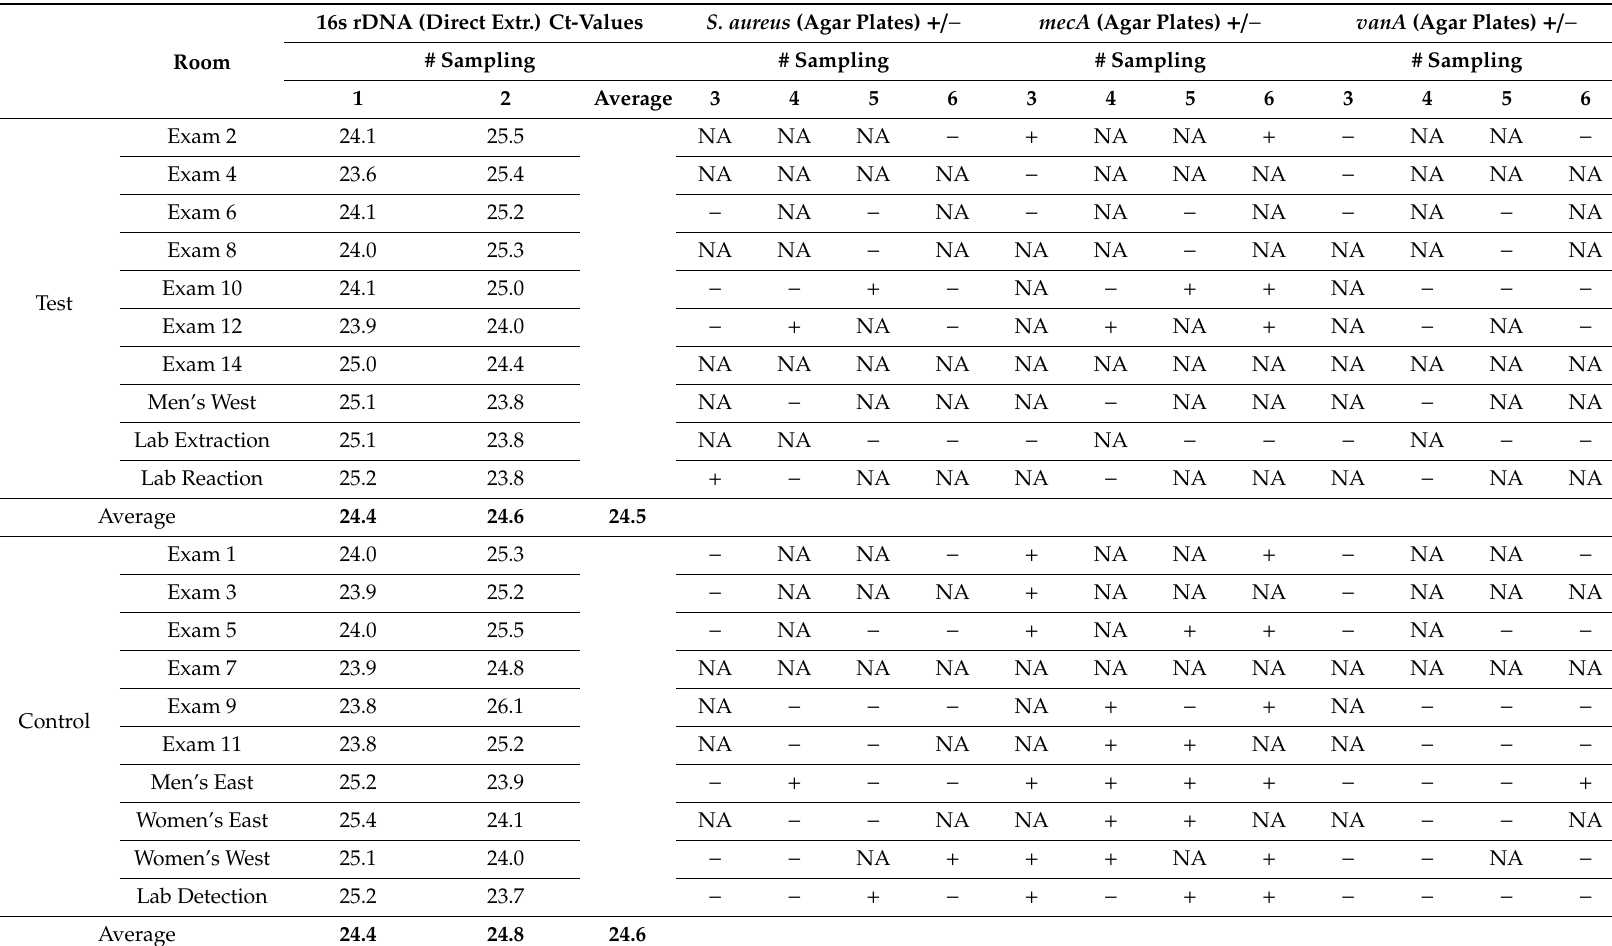
Table 1. Cycle threshold (Ct) values for 16S rDNA from test (copper-silver alloy coated door handles) and control (satin brass door handles) DNA extracts, when DNA extraction was performed directly from the swabs and after the growth step on agar, as described in MM. Occurrence ( +/ − ) of S. aureus, mecA and vanA genes among the selected DNA extracts after the growth step on agar is also reported. NA = not